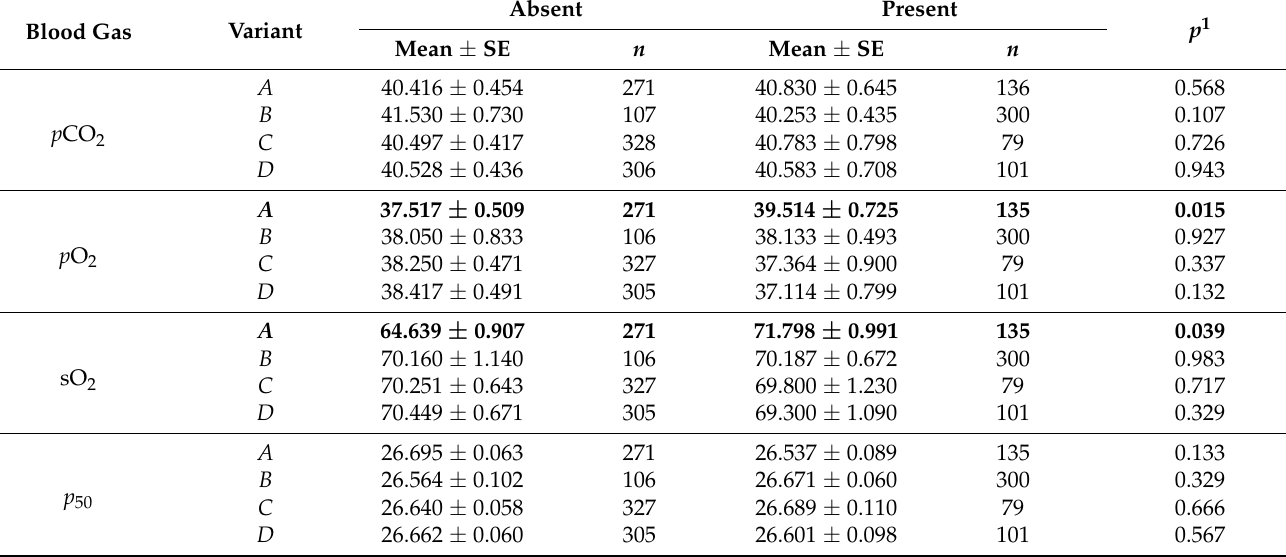
Table 5. Association of EPAS1 variants with blood gas (mean ± SE) 1 in